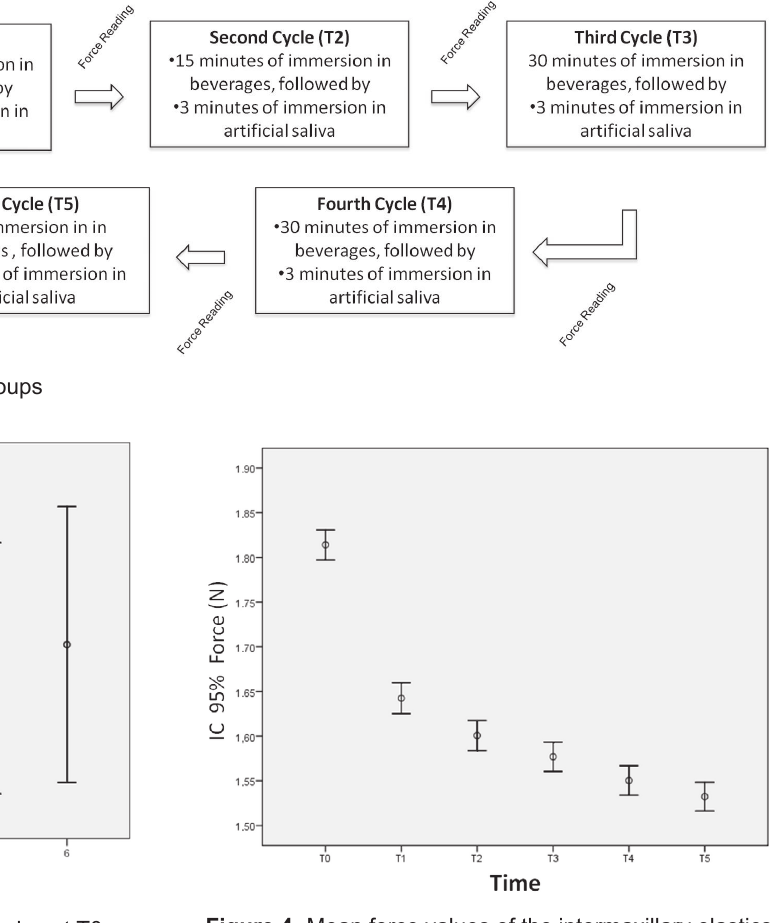
Figure 3- Homogeneous distribution of samples at T0 Figure 4- Mean force values of the intermaxillary elastics regardless of the group